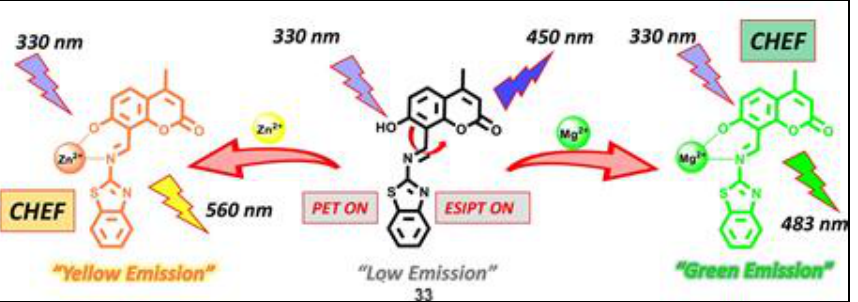
Figure 33. Sensing mechanism of 33 towards Mg 2+ and Zn 2+ ions. Adapted with permission from [108]. Copyright (2023) Elsevier.